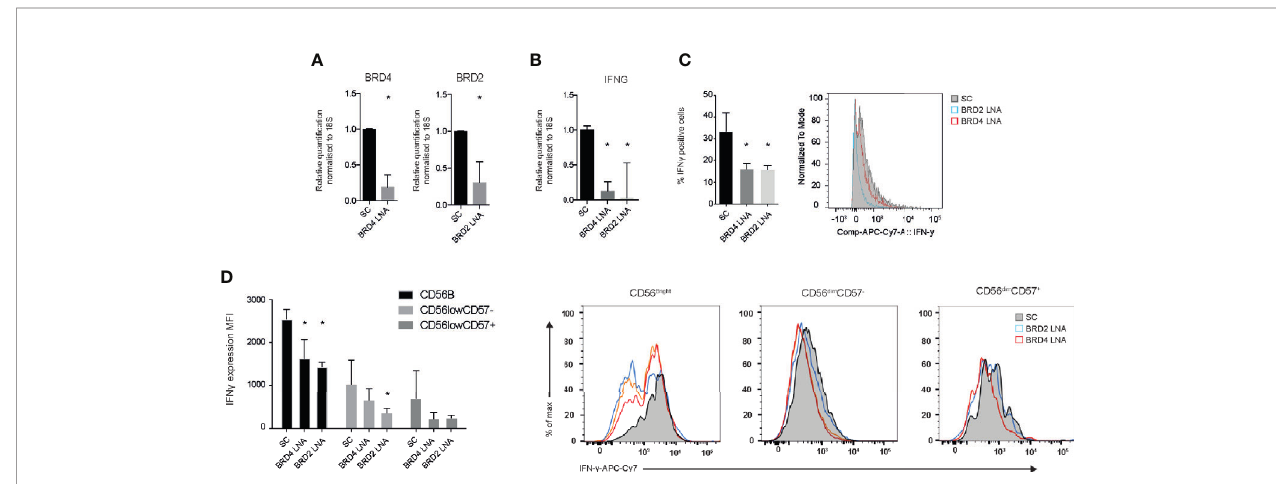
FIGURE 3 | BRD2 and BRD4 regulate NK cell in fl ammatory function. NK cells were cultured in the presence of IL-15 and either scrambled control (SC), BRD2 or BRD4 LNA oligonucleotide (n = 5). (A) Knockdown ef fi ciency was assessed using qPCR. (B) The expression of IFNG gene expression was measured using qPCR. (C) The expression of IFN- g protein in total NK cells was measured using fl ow cytometry. (D) NK cells were further gated based on the expression of CD56 and CD57 and then intracellular IFN- g was measured. A representative fi gure shows the median fl uorescent intensity of IFN- g among CD56 bright CD57 − , CD56 dim CD57 − and CD56 dim CD57 + NK cell populations. The right panel shows a representative fl ow cytometry histogram of IFN- g expression in each NK cell subpopulation. The data are from three independent experiments. The data represents means ± S.D. in (A – D) . P values were calculated using Kruskal – Wallis with Dunn ’ s multiple comparison test *P < 0.05. MFI, median fl uorescence